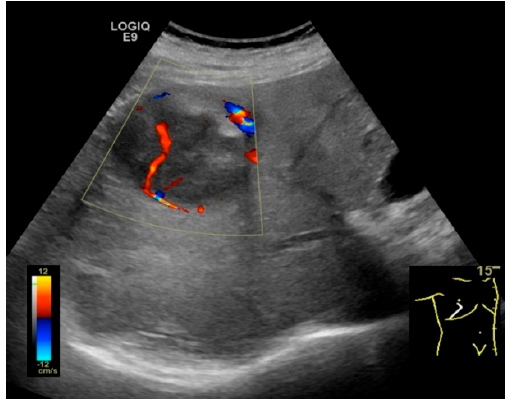
Figure 2. Hepatic steatosis. Focal liver lesion. 2D-US scan shows an enlarged liver with increased echogenicity and posterior beam attenuation. In addition, a focal parenchymal structure is observed in the right lobe. It is characterized as having decreased, heterogeneous echogenicity and internal vessels seen at Doppler examination. The diagnosis of the focal lesion remains uncertain and CEUS examination is